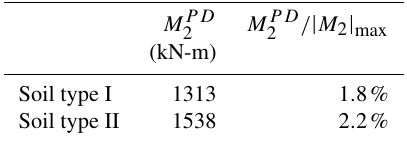
Table 7. Additional loading by the P – (cid:49) effect at the tower base.